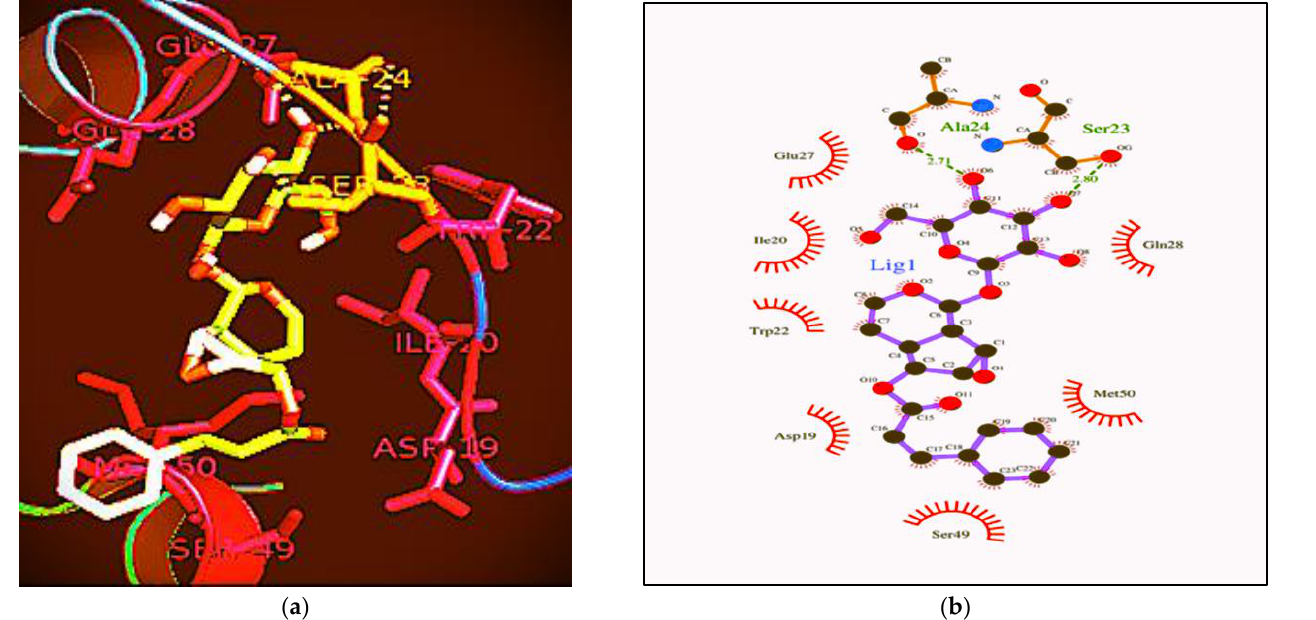
Table 4. Ramachandran plot statistics for the DHFR of Yersinia enterocolitica.